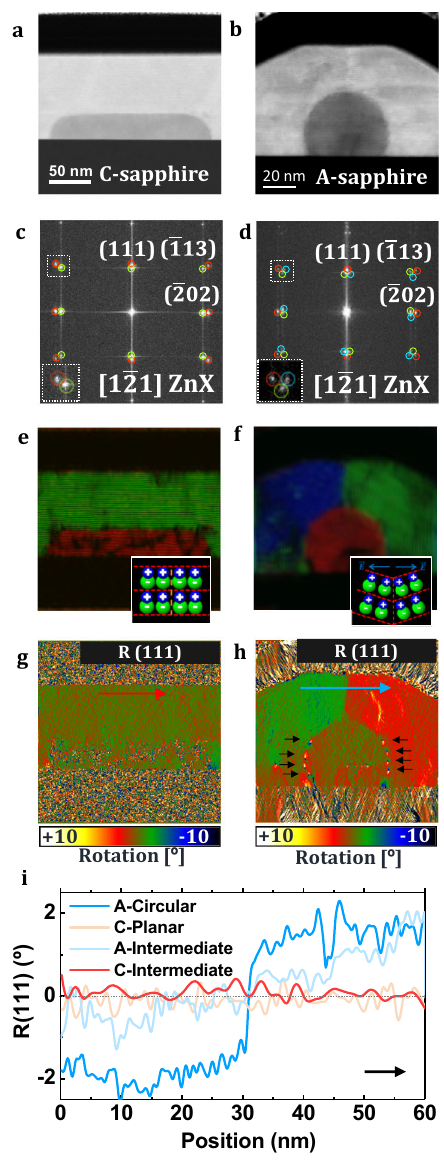
Fig. 2 Study of the shell rotation. Core-shell ZnSe@ZnTe NWs on C-plane sapphire (left, a , c , e , g ) and A-plane sapphire NWs (right, b , d , f , h ). a , b Low-magni fi cation atomically resolved HAADF STEM image showing a representative NW cross-section. c , d Plane-indexed FFTs corresponding to ( a ) and ( b ), highlighting ZnSe core planes (red) and ZnTe shell planes (green/blue to differentiate orientations) in these structures. e , f Frequency- fi ltered RGB structural maps (IFFT) with color codes as indicated in ( c ) and ( d ). The insets schematically show dumbbell orientations in the central part of the ZnTe shell. g , h GPA (111) plane rotation (R) maps relative to the NW core planes, which are taken as reference. Color bars represent the geometrical phase analysis calculated (111) planes rotation in degrees (°). Black arrows in ( h ) indicate dislocation positions. i (111) plane rotation pro fi les across the center of the NW shell (following the directions indicated by the red and blue arrows in ( g ) and ( h ), respectively) for relevant core morphologies in both C-plane and A-plane